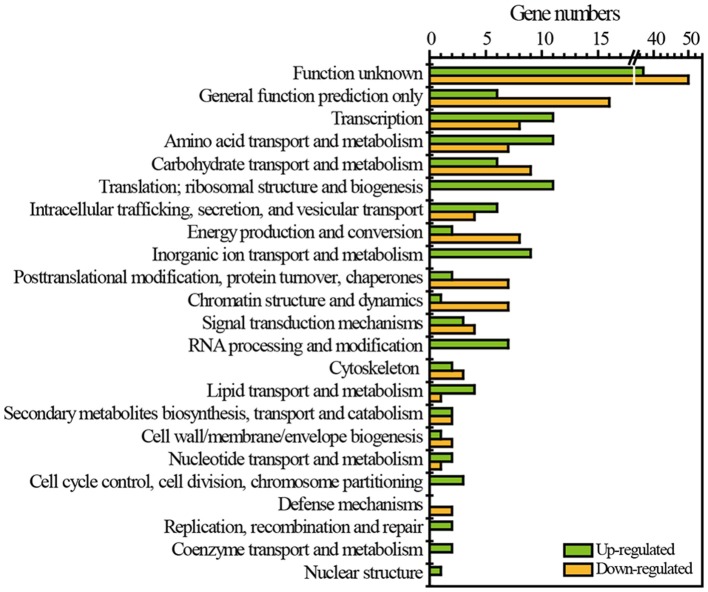
Functional classes of DEGs of Z. bailii MT15 at 30 and 37°C using eggNOG functional categories.